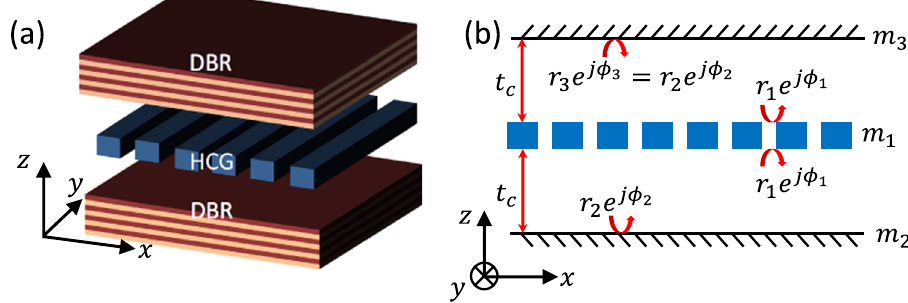
Figure 1. ( a ) Schematic view of a system of two coupled vertical cavities realized by a HCG reflector (coupling mirror m 1 ) and two conventional DBRs (outer mirrors m 2 and m 3 ). ( b ) The schematic cross-sectional view of ( a ), where m 2 and m 3 are shown as simple reflectors, and assumed to be similar. The mirror reflection amplitudes, r i (real and positive), phases, φ i (0–2 π ), and nominal cavity length, t c are defined as shown in